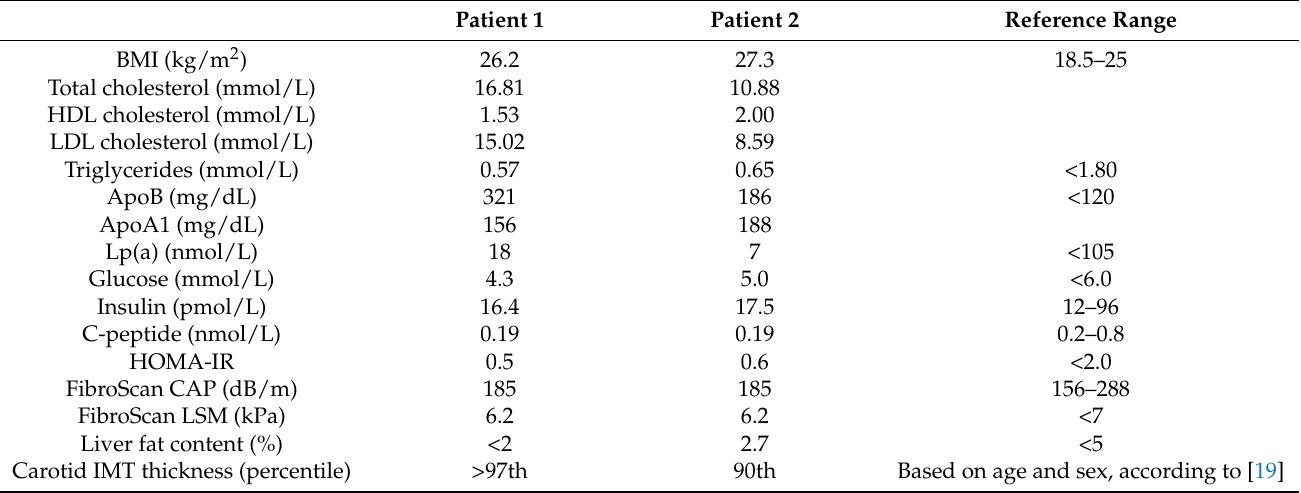
Table 1. Summary of laboratory and imaging results derived from patients 1 and 2 adhering to a carnivore